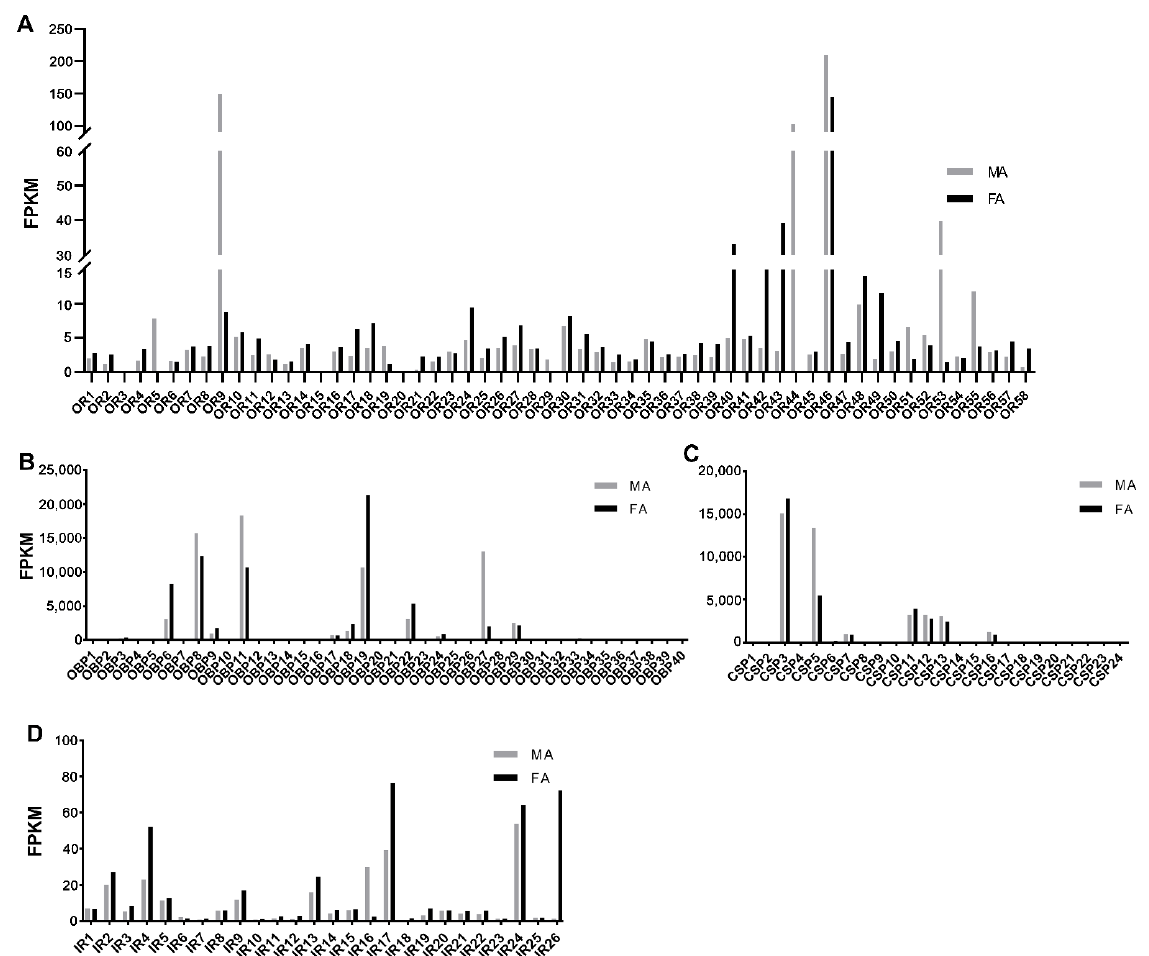
Figure 6. Expression levels of ORs, OBPs, CSPs, and IRs in Scopula subpunctaria antennae based on the FPKM values. ( A ): FPKM values of ORs in S. subpunctaria antennae. ( B ): FPKM values of OBPs in S. subpunctaria antennae. ( C ): FPKM values of CSPs in S. subpunctaria antennae. ( D ): FPKM values of IRs in S. subpunctaria antennae. FA, antennae of female individuals; MA, antennae of male